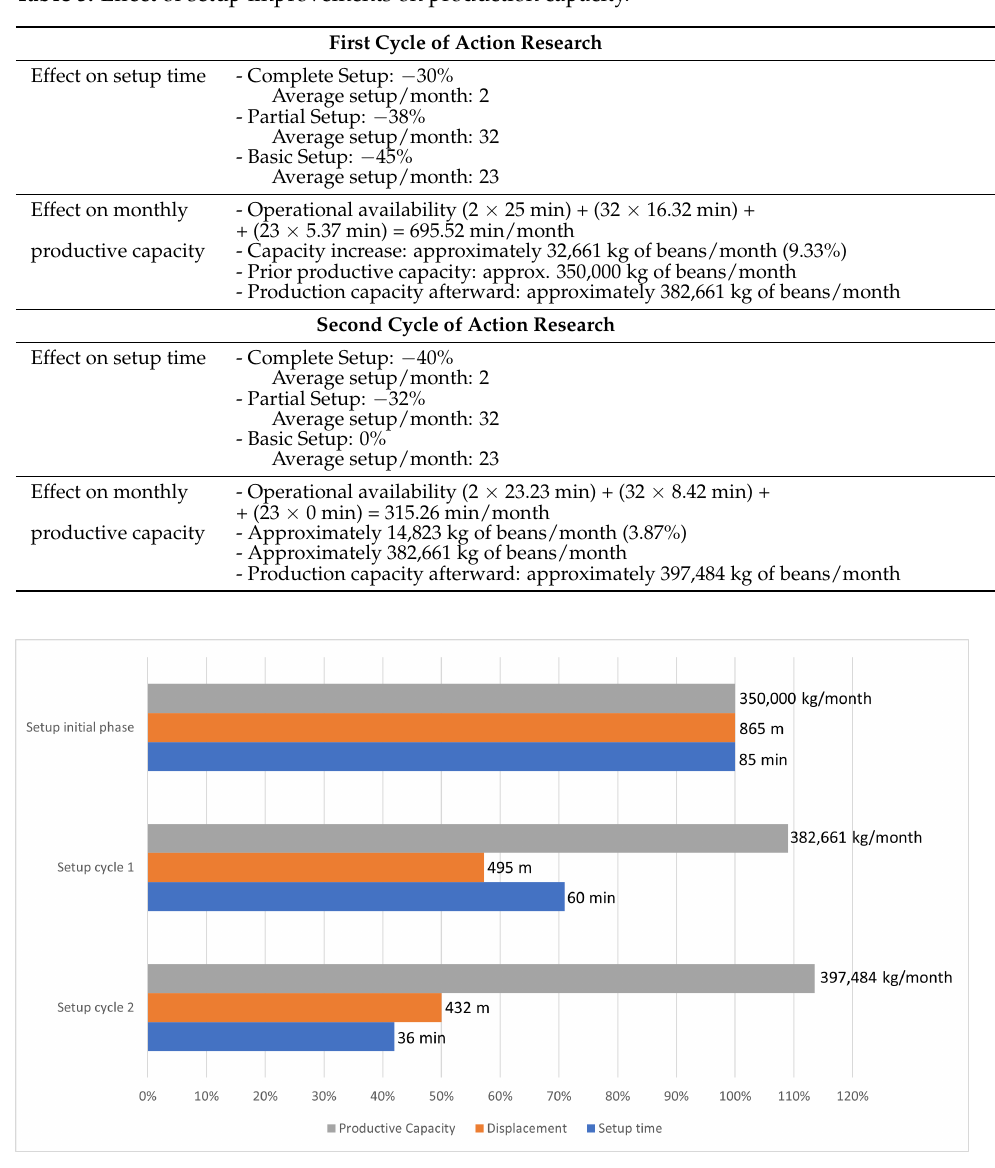
Figure 7. Result at the end of each action research